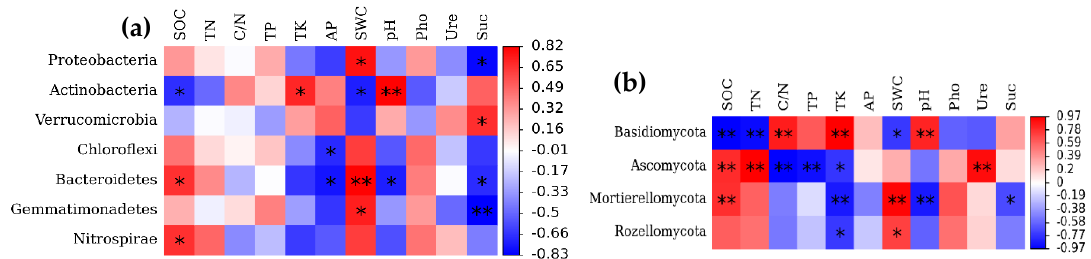
Figure A1. Correlation analysis between bacterial ( a ) and fungal ( b ) phylum communities and soil properties in broad-leaved Korean pine forest at different succession stages in Lesser Hinggan Mountains. SOC, TN, TP, TK, AP, SWC, Pho, Ure, Suc represents the abbreviations of soil organic carbon, total nitrogen, total phosphorus, total potassium, available phosphorus, soil water content,